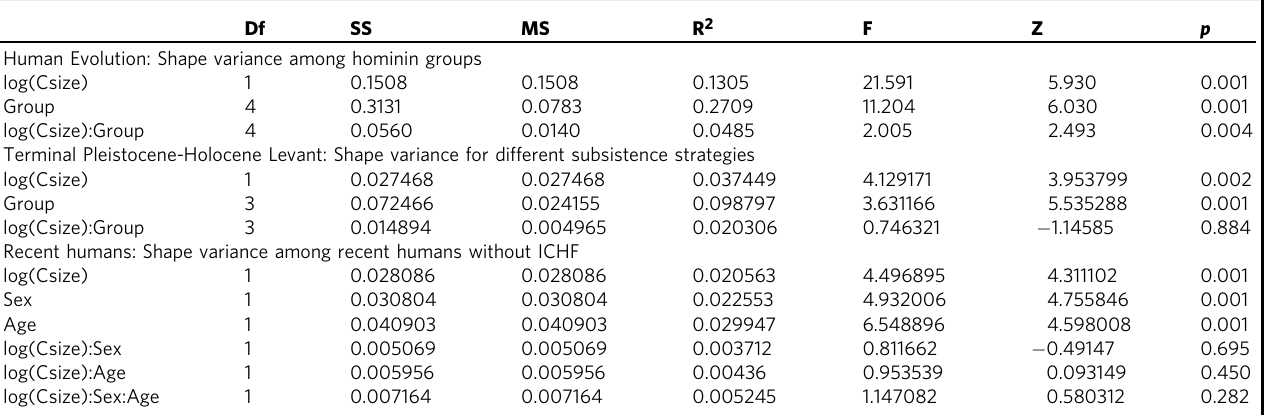
Table 1 Procrustes ANOVA analyses for proximal